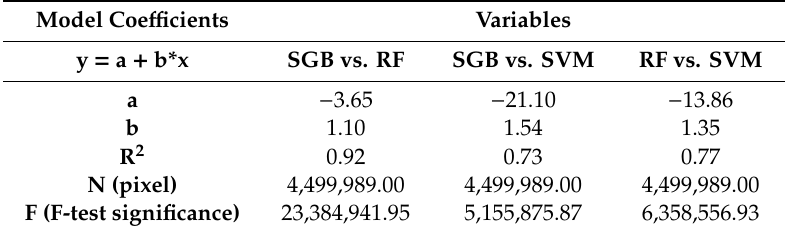
Figure 4. Spatial distribution (upper row) and di ff errence (lower row) of C:N ratio bewteen models across the whole Sundarbans Reserved Forest for 2009–2010. SGB: Stochastic gradient boosting, RF: Random Forest and SVM: Support Vector Machine. Table 5. Spatial relationship between di ff erent modeling methods in predicting C:N ratio across the whole Sundarbans Reserved Forest. SGB: Stochastic gradient boosting, RF: Random Forest and SVM: Support Vector Machine. a: intercept and b: